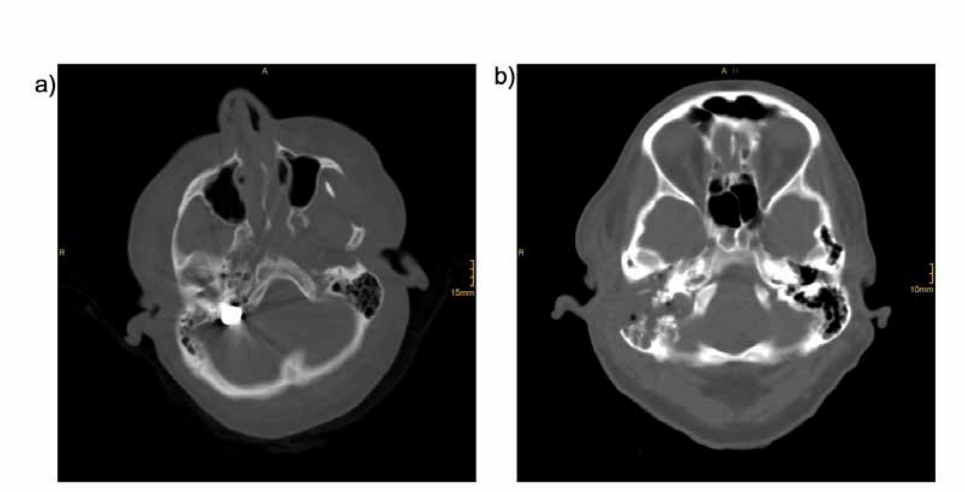
Figure 3 a-b: Axial computed tomography image of the base of the skull showing the bullet within the distal part of the sigmoidal sinus on the right side (a). A bony defect is seen after transmastoidal removal of the bullet